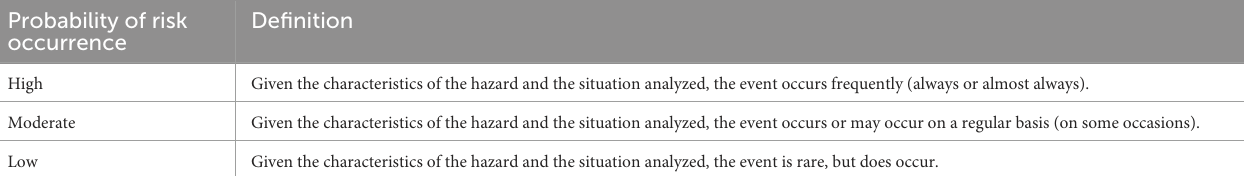
TABLE 4 Criteria to estimate risk occurrence